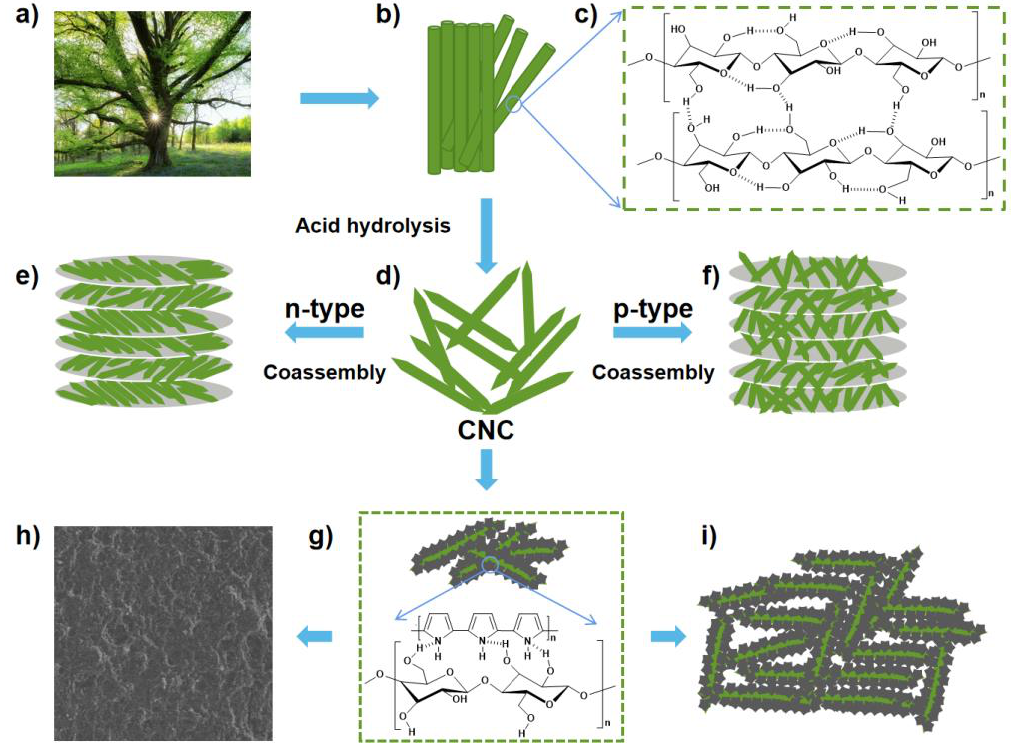
Figure 3. Structure and wrapping structure of PPy/CNCs. ( a ) Tree; ( b ) Cellulose fiber; ( c ) The molecular structure of cellulose; ( d ) CNC obtained by acid hydrolysis. ( e ) The co-assembly process of CNC and n-type material. N-type material refers to the material mainly conductive by electrons. CNC molecules are orderly arranged in layer upon layer in composite materials. ( f ) The co-assembly process of CNC and p-type material. P-type material refers to the material mainly conductive by holes. CNC molecules are distributed disordered and superimposed layer by layer to form composite materials. ( g ) The wrapping structure of PPy/CNCs and the possible bonding modes of hydrogen bonds. ( h ) PPy/CNCs composite conductive layer; ( i ) Possible sedimentary structure of PPy/CNCs.